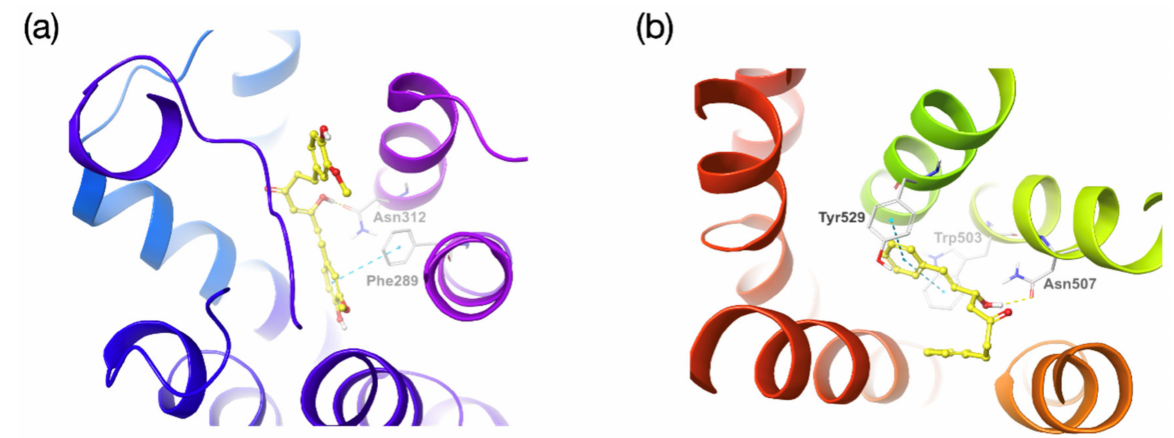
Figure 7. Docking poses of ( a ) compound 9 to β 2-AR and ( b ) compound 19 to M3. The ligands and amino acid residues of the binding pockets are shown in the sticks. The hydrogen and pi-pi bonds are represented as yellow and blue dashed lines, respectively. The carbon atoms of the ligands and the residues are colored yellow and grey, respectively. Nitrogen, oxygen and hydrogen atoms are colored blue, red and white,